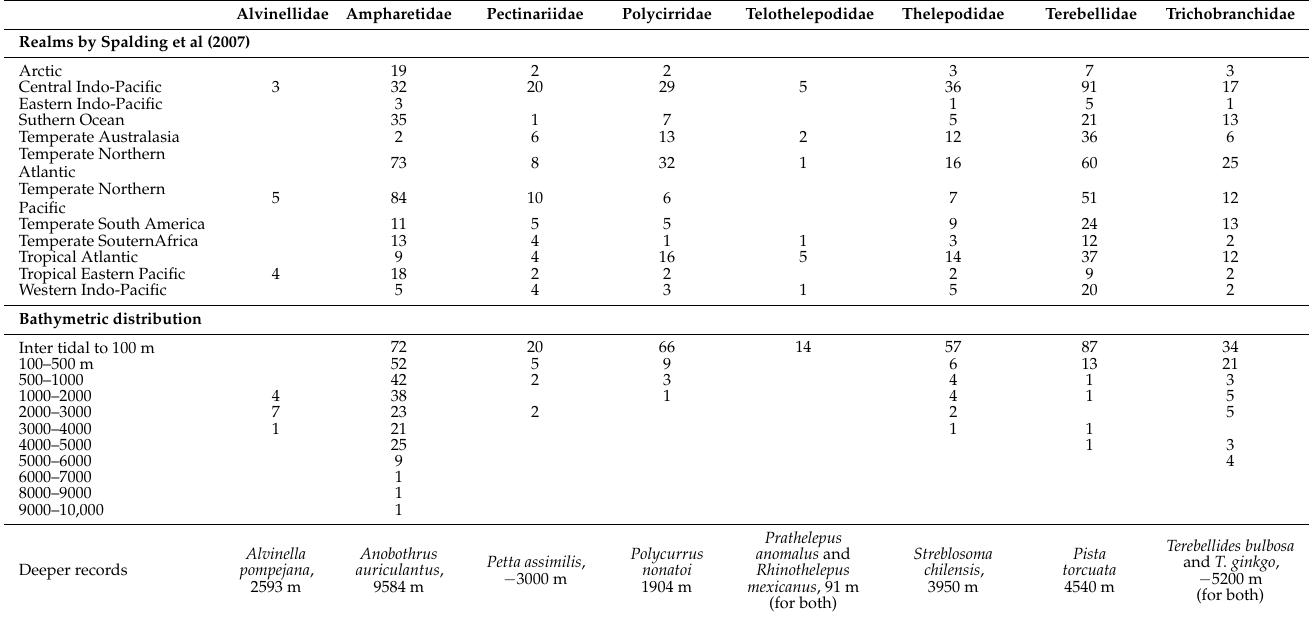
Table 2. Distribution of Terebelliformia around the world, following the marine regionalization created by Spalding et al. [10], and bathymetric variation of the terebelliform families, as well as the deepest records of each group. Alvinellidae Ampharetidae Pectinariidae Realms by Spalding et al (2007) Arctic